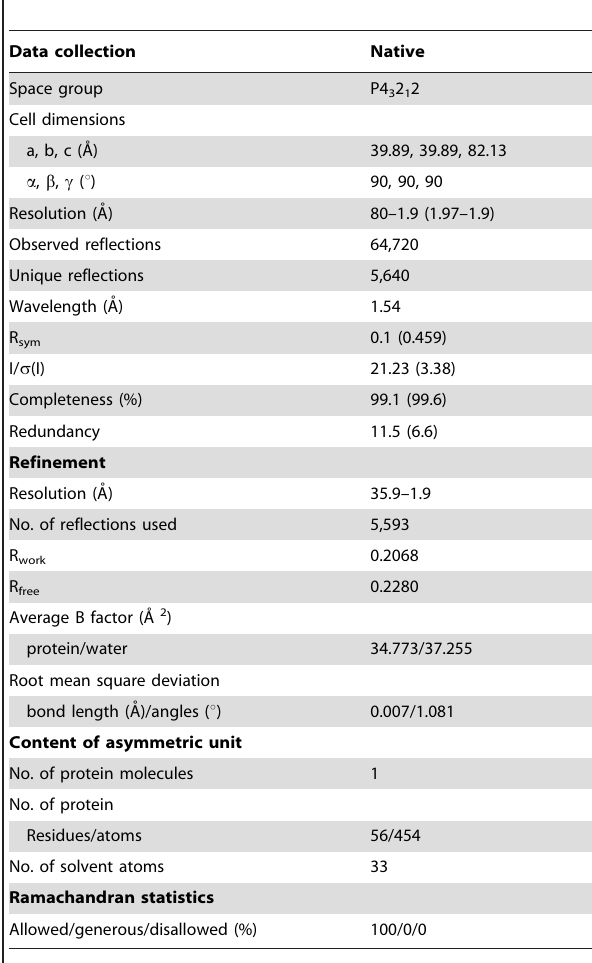
Table 2. Crystallographic statistics of the structure of the frog DGCR8 dimerization